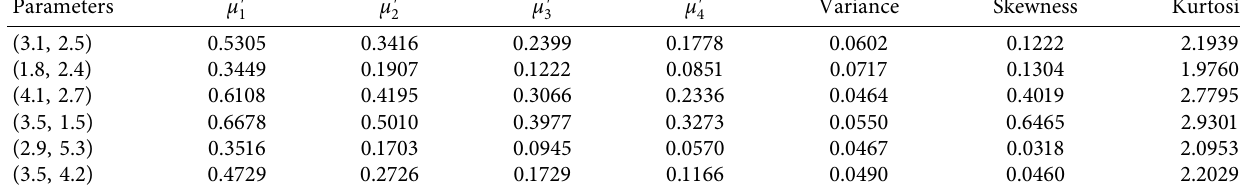
Table 1: Te r th moments, variance, skewness, and kurtosis of MKw ( a , b ) distribution for diferent parameter values. Parameters